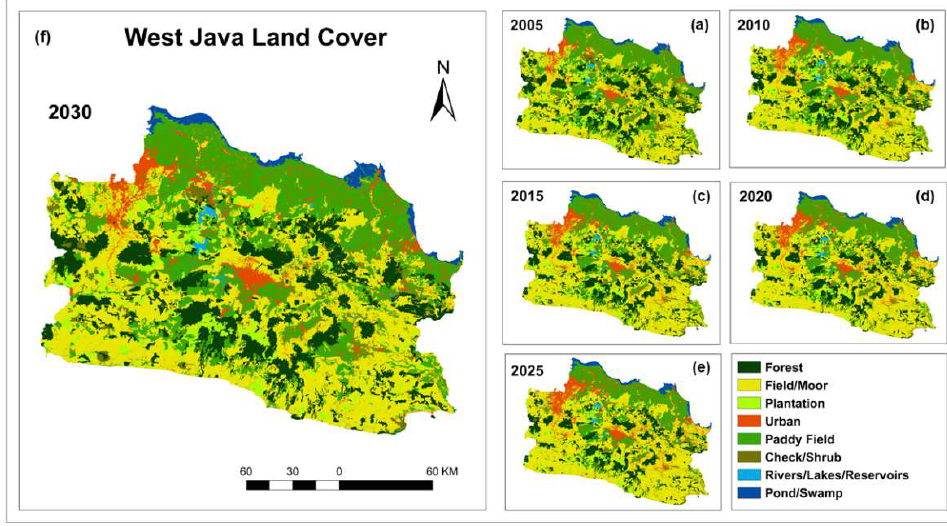
ISPRS Int. J. Geo-Inf. 2022 , 11 , x FOR PEER REVIEW Figure 4. Land cover predictions in ( a ) 2005, ( b ) 2010, ( c ) 2015, ( d ) 2020, ( e ) 2025, and ( f ) 2030. The first product produced is a land cover prediction based on the land cover in 2005 and 2010. Land cover prediction is carried out over five periods, namely 2015, 2020, 2025, and 2030. Based on these land cover predictions, there is a decrease in the area of paddy fields from year to year. In 2030, the decrease in the paddy fields area was 31% from 2005. This condition impacts the decline in rice productivity in the West Java Province. This conclusion is directly proportional to the statement from [58], which stated that the land cover area in Indonesia continuously decreases by 650,000 ha per year. The paddy fields area decline in West Java has also been proven by [6]; there was an area decrease of 17.35%, from 1,189,728.85 ha in 2006 to 983,342.77 ha in 2016 [6]. The graph of the decline in paddy fields can be seen in Figure 5 and Table 3.